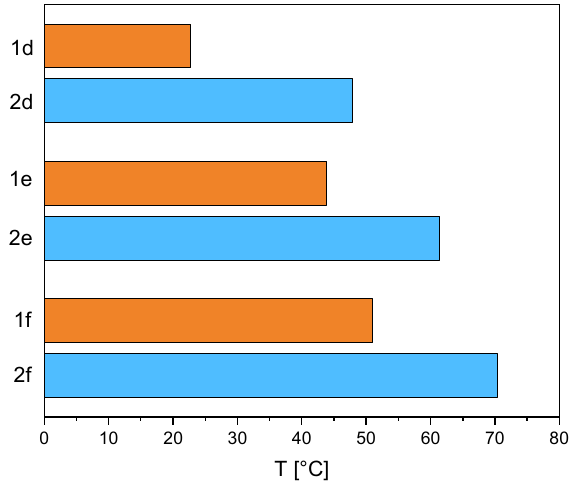
Figure 3. Comparison of the mesophase range of the salts 1d-f and 2d-f .